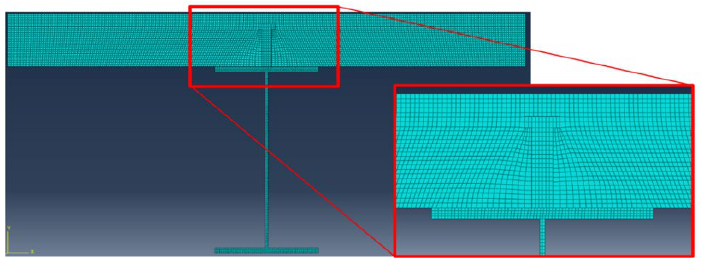
Figure 5. Finite element mesh of the composite beam 1